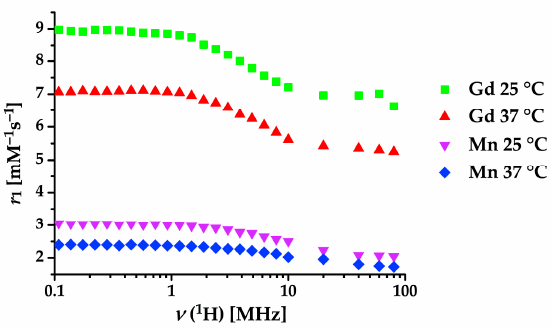
Figure 4. 1 H NMRD profiles of Mn(II)–1,4-H 4 do2p (pH 9.5, ~100% [Mn(1,4-do2p)] 2 − ) and Gd(III)–1,4-H 4 do2p (pH 8.5, ~100% [Gd(H 2 O) x (1,4-do2p)] − ) systems.